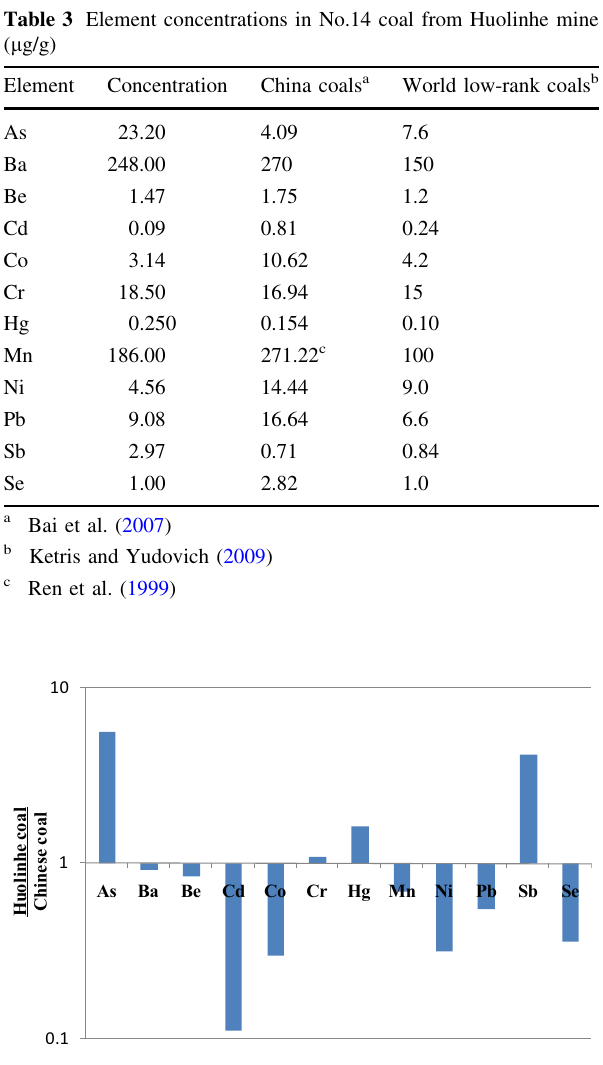
Fig. 5 Comparisons between the concentrations of trace elements in Huolinhe coal and those in Chinese coals